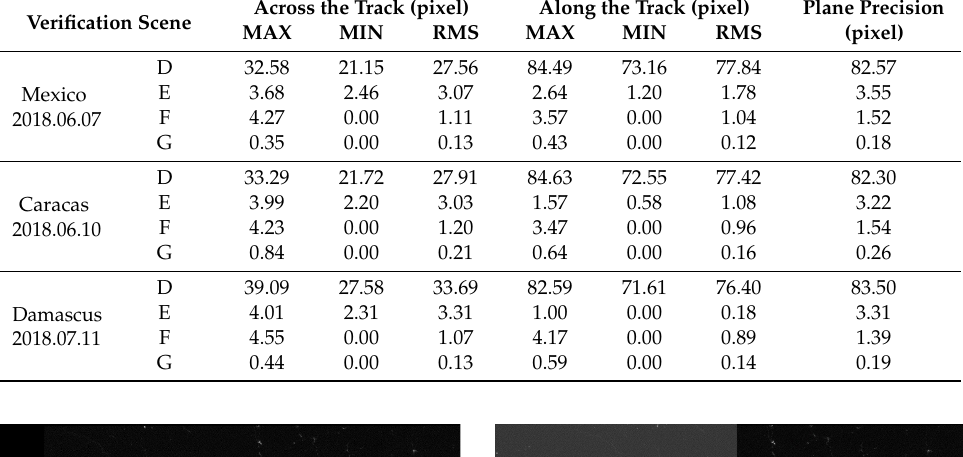
Table 7. Accuracy of multi-temporal registration.